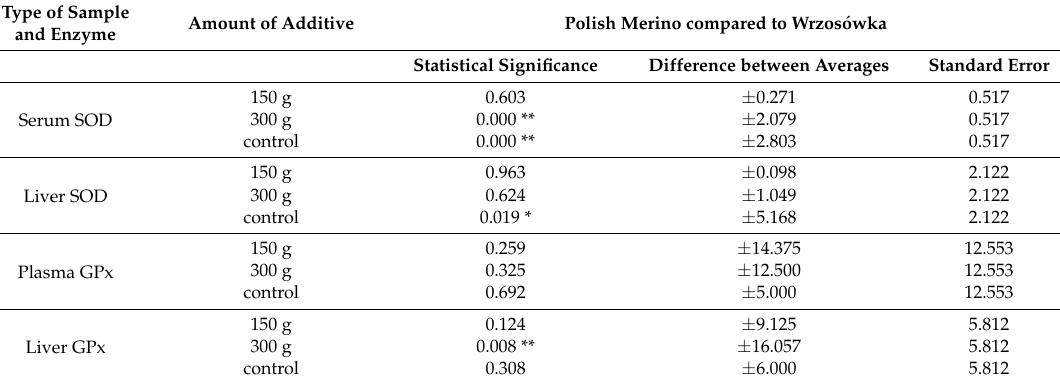
Table 2. Differences between the antioxidative enzyme activity of each pair of breeds.